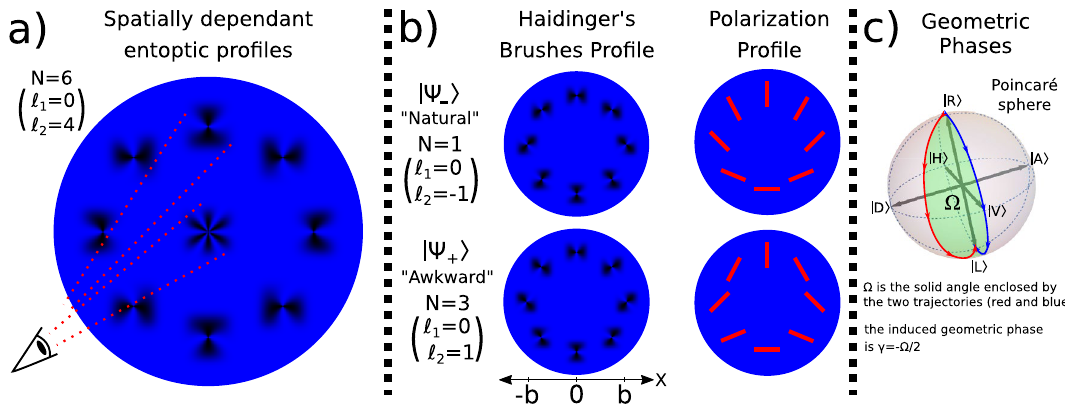
Figure 1. ( a ) Pictorial representation of the spatially dependant entoptic profiles that a human observer would perceive when directly viewing different regions of a spin-orbit beam described by Eq. (1) where ℓ 1 4 . If the observer looks at the polarization gradient in the center they will perceive ℓ 2 = azimuthal fringes. If the observer looks at a region away from the center where the polarization is roughly uniform in the field of vision, they will observe specifically oriented Haidinger’s brushes. ( b ) In this study the strong polarization gradients in the central region of the beam were reduced by preparing spin-orbit states with radially dependent terms, as described by Eq. (2). The distance at which there is an equal amount of the two circular polarization states is denoted by b , and in our particular setup b was approximately 1.5 cm. The beam state was not varied with time, and the participants were asked to move their gaze around the perimeter of the beam while observing and discriminating the elicited Haidinger’s brush profile, labelled either the “awkward” or “natural” profile depending on whether the entoptic brush appeared to rotate along or against the observer’s eye movement. In order to minimize visual adaptation to optical polarization the suggested speed for the self- generated circular eye motion was 1 Hz. ( c ) To visually depict the role of the geometric phases in the preparation of the shown profiles, we can map the evolution of polarization from r = 0 to r = 2b (from Poincaré sphere 39,40 . The geometric phase is given by γ trajectories. Considering that in the preparation of the shown polarization profiles the azimuthal coordinate φ determines the angle between the corresponding trajectories on the Poincaré sphere, it follows that the geometric phase gives rise to an OAM term e ±